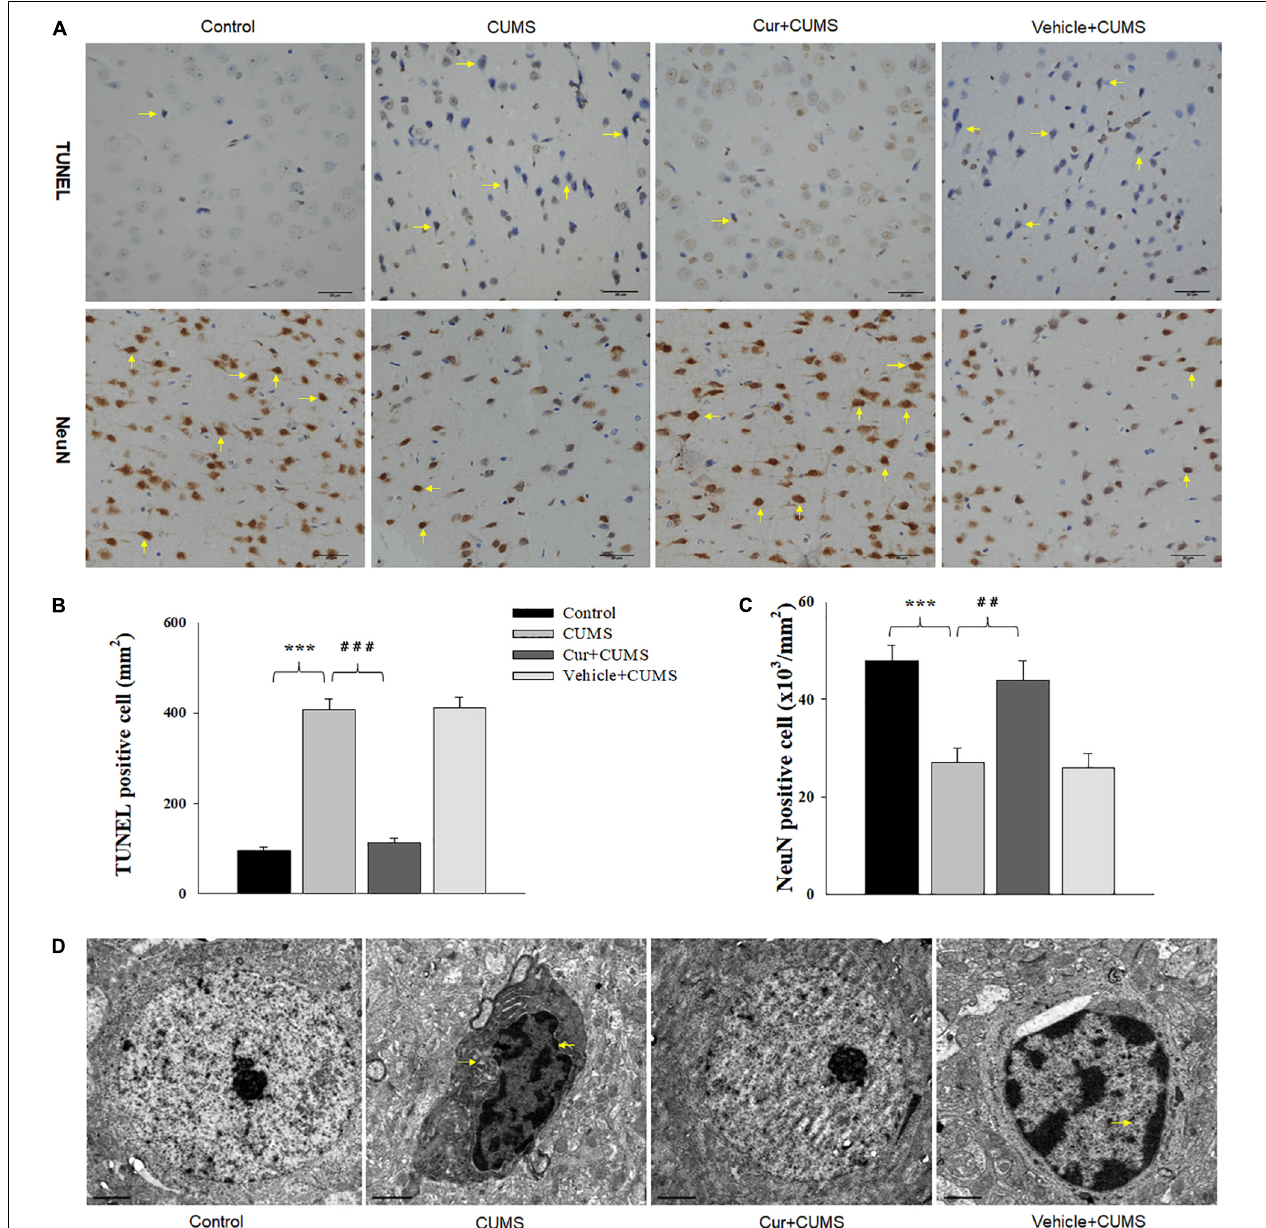
FIGURE 3 | Curcumin ameliorated neuronal apoptosis within the vmPFC as induced by CUMS exposure. (A) Curcumin treatment decreased the number of TUNEL positive apoptotic cells (top, indicated by the arrows) and NeuN positive cells (bottom, indicated by the arrows) in the vmPFC of CUMS-exposed rats. Scale bar is 20 µ m. (B) Histograms showing the increased TUNEL positive cells were significantly attenuated by curcumin pretreatment. (C) Histograms showing the decreased NeuN positive cells was significantly attenuated by curcumin pretreatment. (D) Representative electron micrograph of vmPFC neuronal ultrastructure. Arrows indicate nuclear chromatin aggregation, condensation and margination. Scale bar is 2 µ m. Curcumin significantly ameliorated apoptosis of vmPFC neurons in CUMS-exposed rats. N = 6/group. ∗ P < 0.05, ∗∗ P < 0.01, ∗∗∗ P < 0.001 CUMS vs. Control group (non-stressed). # P < 0.05, ## P < 0.01, ### P < 0.001 Cur + CUMS vs. CUMS